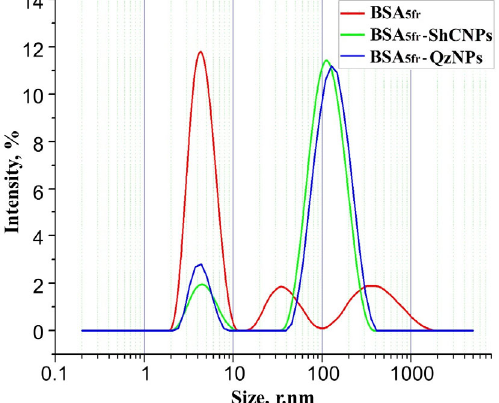
Figure 3. Examples of the dynamic light scattering (DLS) data on the distribution of the relative intensity of scattered light by particle size (Stokes diameter) for native BSA 5fr (containing fatty acids, fraction V) at concentration 30 mg/mL in 0.2 M phosphate-buffer solution (pH 5.2) (red), in 0.035 mg/mL ShC dispersion (green), and in 0.67 mg/mL quartz dispersion (blue) at 25 °C.